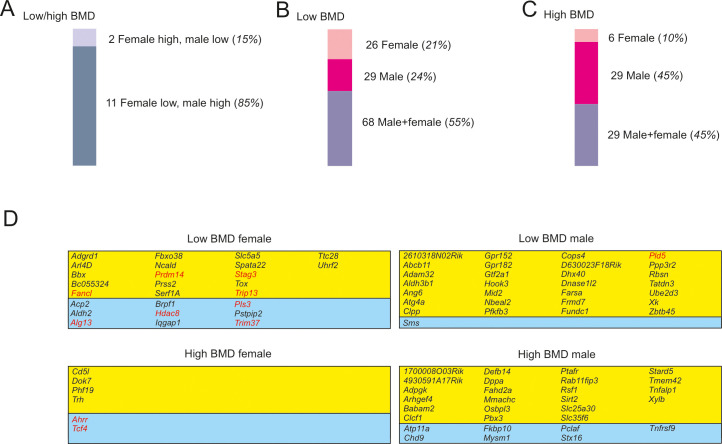
BMD genes displayed sexual dimorphism.(A-C) A subset of 90 genes affected BMD specifically in one sex. The 90 genes encompass in females (pale pink bars) 26 low BMD and 6 high BMD genes plus in males (magenta) 29 low BMD and 29 high BMD genes. (D) The identity of all sexually dimorphic genes grouped by class and direction of BMD change. Genes with a previously reported role in sexual dimorphism other than bone are marked red.